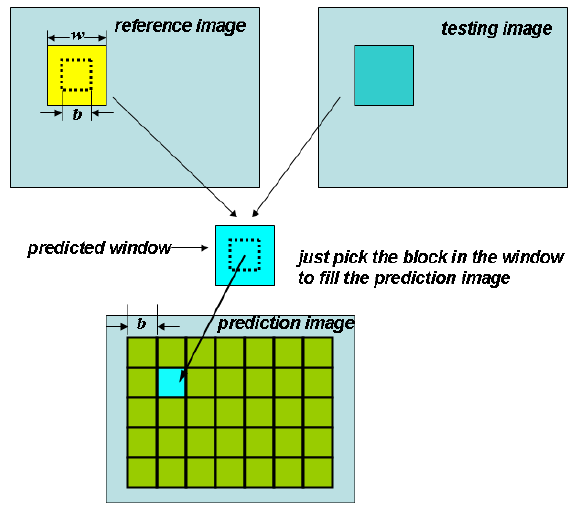
Figure 2. Local prediction idea.